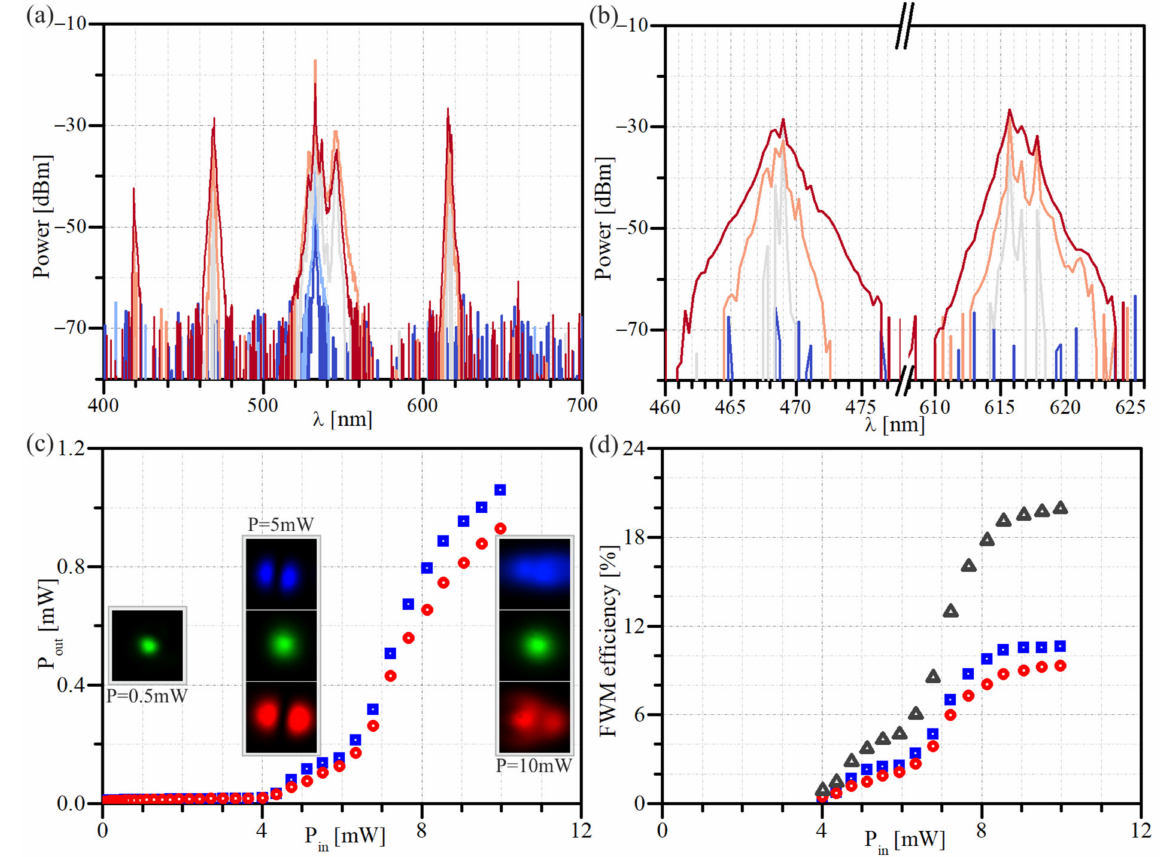
Figure 4. The experimental results of the FWM process realized in 0.8 m FUT: ( a , b ) output spectra for pump power 0.5 mW (dark blue), 2.0 mW (light blue), 5.0 mW (light grey), 7.0 mW (orange) and 10.0 mW (dark red); ( c ) power of the Stokes (617 nm—red circles) and anti-Stokes (470 nm—blue squares) beams; ( d ) wavelength conversion efficiency, plotted as a function of the power of the pump beam (532 nm); calculated for the Stokes (red circles), anti-Stokes (blue squares) and both Stokes (dark grey triangles) beams. The insets in ( c ) present the modal field distribution at the fiber output for 0.5 mW, 5.0 mW and 10.0 mW pump beam